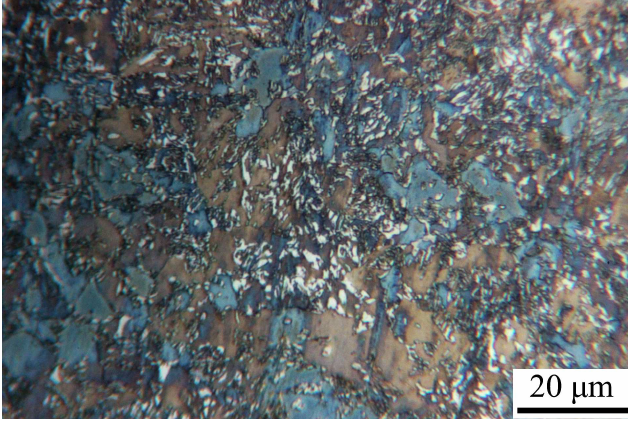
Figure 6. Micrograph of the TRIP